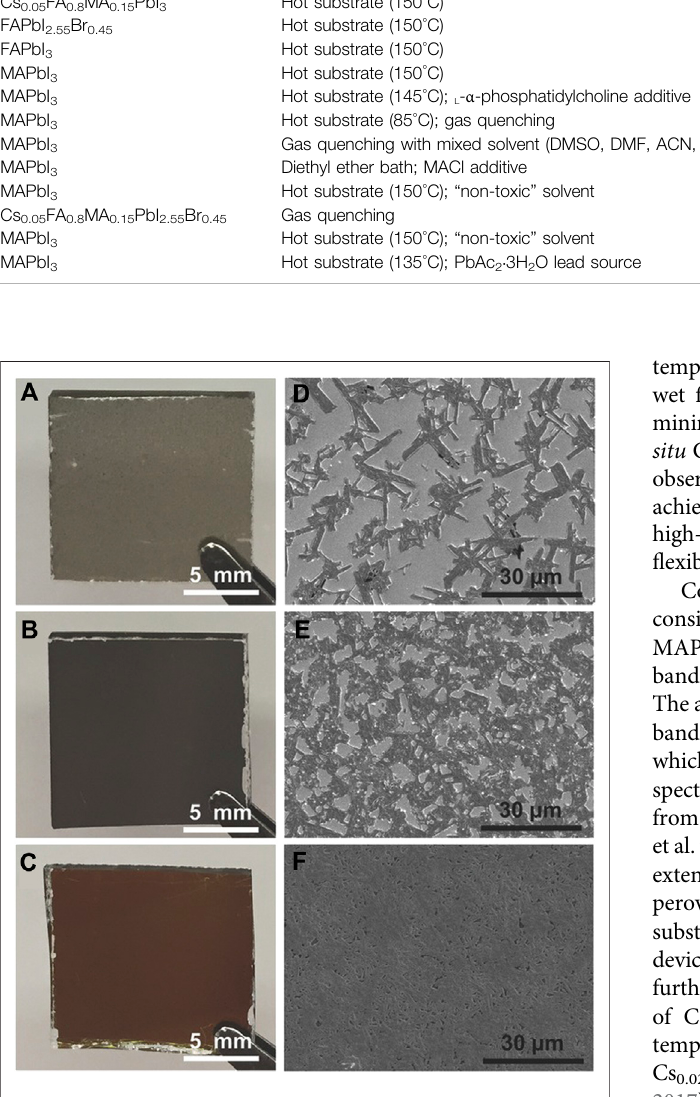
FIGURE 5 | Photographs and SEM micrographs of the perovskite thin fi lmsfabricatedbyblade-coatingtechniqueatdifferentRHlevels.Imageswere takenat (A,D) RH (cid:2) 50 – 70%, (B,E) RH (cid:2) 40 – 50%,and (C,F) RH (cid:2) 15 – 25%. A compact perovskite fi lm was obtained under RH (cid:2) 15 – 25%, and needle-like crystallites were observed for the sample fabricated under RH (cid:2) 60 – 70%. Reprinted with permission from Yang et al. (2015). Copyright 2015 WILEY-VCH Verlag GmbH & Co. KGaA,